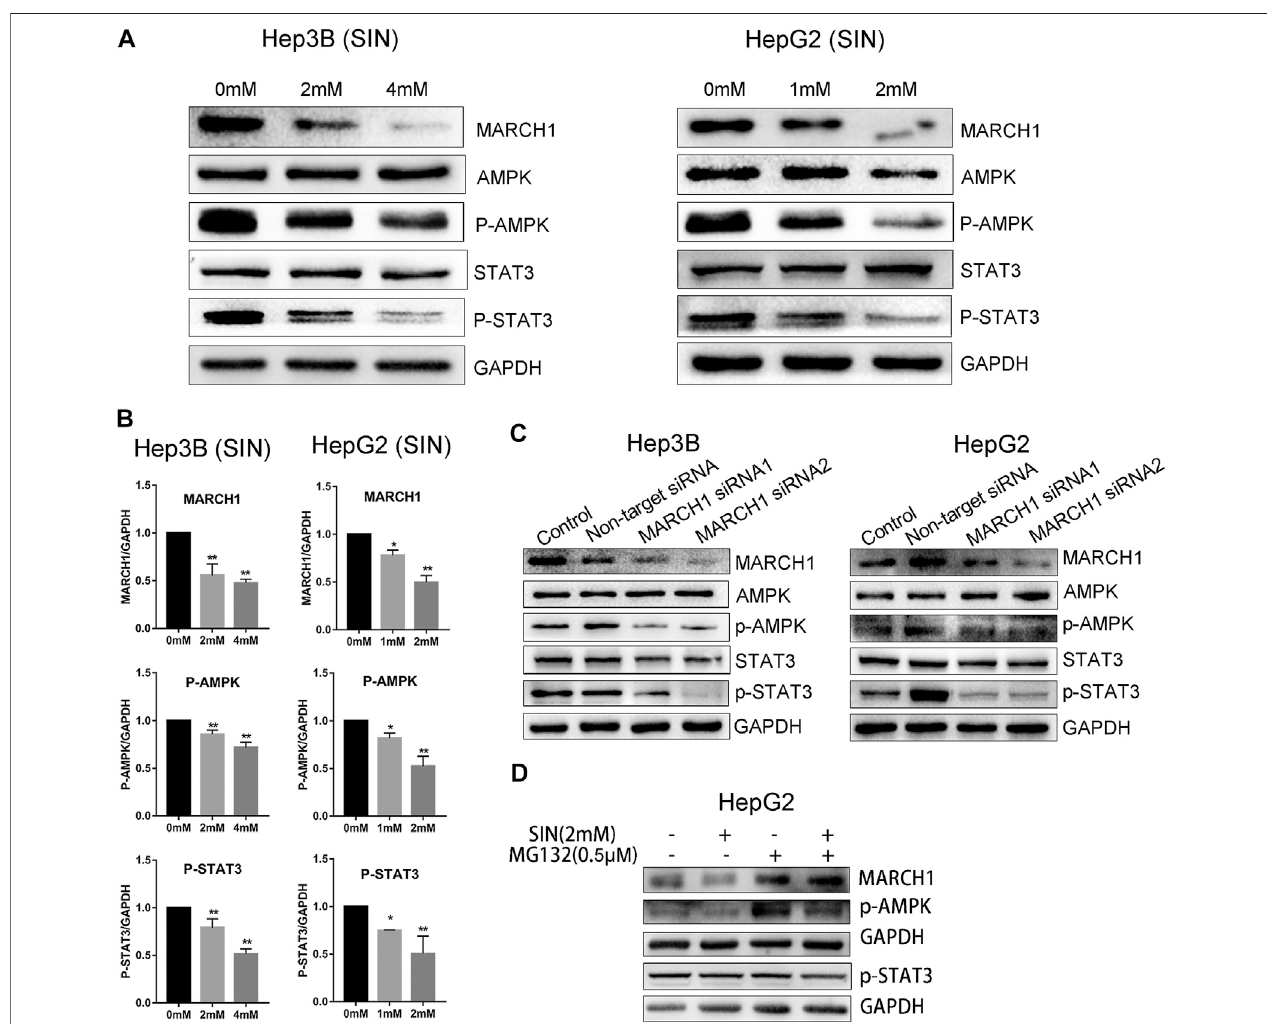
FIGURE 2 | SIN decreased phosphorylation of AMPK and STAT3 via inhibiting MARCH1. (A) The expression of MARCH1 and AMPK/STAT3 signaling molecules detected by Western Blotting in Hep3B and HepG2 cells treated with SIN for 24 h. (B) The protein expression of MARCH1, p-AMPK and p-STAT3 quanti fi ed by measuringthegray band value using photoshop CS6.GAPDHwasused for normalization. 0 mM ascontrol. (C) The protein expression ofAMPK, p-AMPK,STAT3 and p-STAT3 after MARCH1 knockdown in Hep3B and HepG2 cells. (D) p-AMPK and p-STAT3 expression were detected when HepG2 cells were treated with SIN and MG132. All data are means ± SD of results from three experiments. * represents p < 0.05, ** represents p <